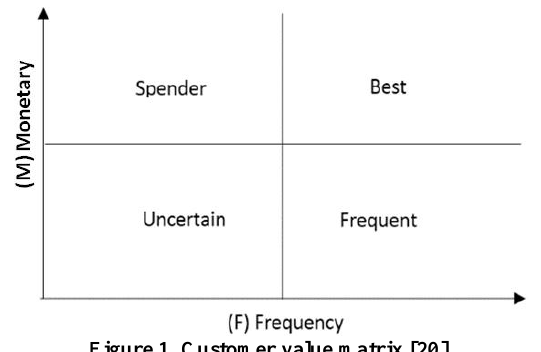
Figure 1. Customer value matrix [20].